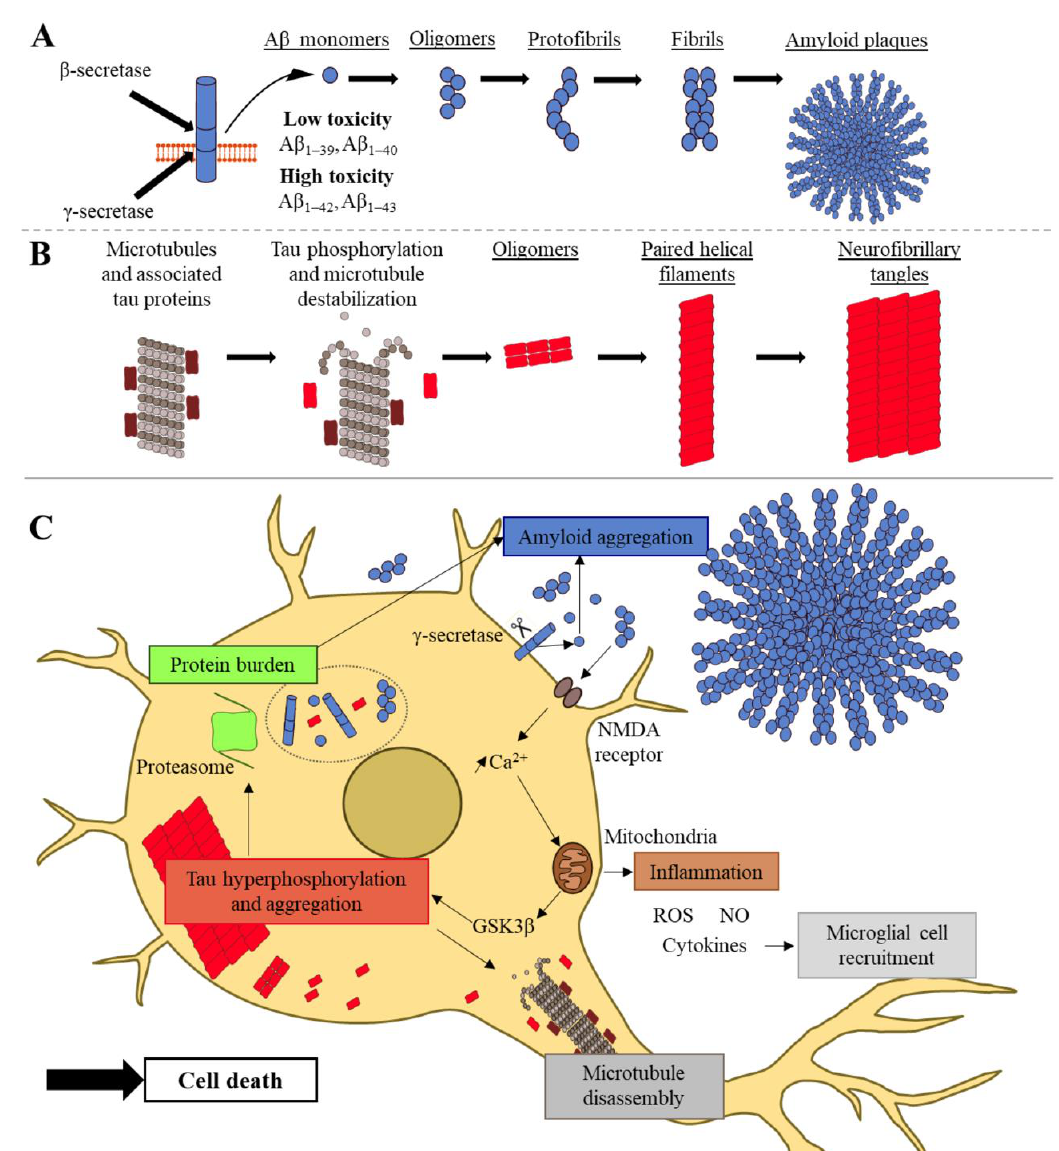
Figure 1. Molecular features of Alzheimer’s disease: from amyloid and tau aggregation to cell death. ( A ) Amyloid peptide production and aggregation. The APP transmembrane protein (blue cylinders) is cleaved by β - and γ -secretases, which generate A β peptides (blue circles). In a pathological context, these A β peptides aggregate into toxic oligomers, which form protofibrils, fibrils, and finally, amyloid plaques. ( B ) Tau aggregation. Tau proteins (dark red rectangles) are associated with microtubules (gray assemblies). During the pathological process, tau proteins are hyperphosphorylated (light red rectangles) and detach from microtubules, which disassemble during the pathological process. Hyperphosphorylated tau proteins aggregate into oligomers, forming paired helical filaments and neurofibrillary tangles (NFTs). ( C ) Summary of the molecular interactions occurring in a neuron during AD and illustration of a tau–A β vicious circle. On one hand, A β oligomers increase intraneuronal calcium, inducing inflammation, microglial recruitment, and tau aggregation. On the other hand, the hyperphosphorylation of tau induces microtubule disassembly and tau aggregation. In turn, the excess of tau aggregates decreases A β peptide degradation by disturbing the proteasome. All these processes lead to neuronal cell death. Abbreviations. NMDA: N -methyl- D -aspartate; GSK3 β : glycogen synthase kinase 3 beta; ROS: reactive oxygen species; NO: nitric